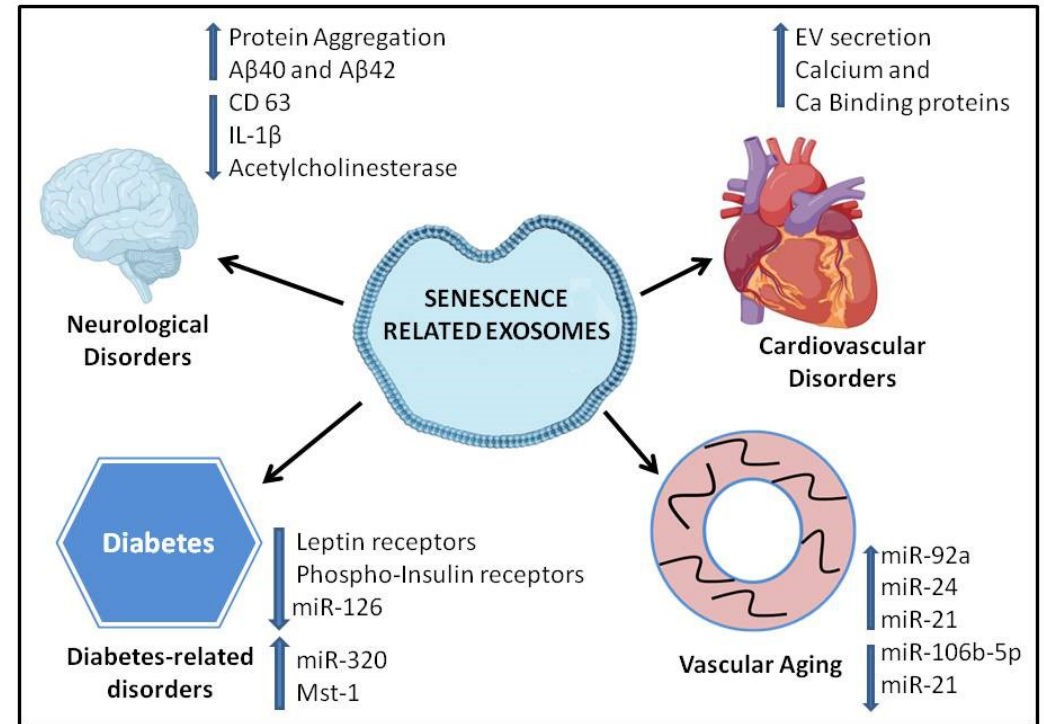
Figure 2. Age-related complications of senescent cell derived exosomes. Extracellular vesicles (EVs) secreted from senescent cells have been implicated in cardiovascular diseases, diabetes, neurological disorders, and vascular aging. Senescent EVs modulate several di ff erent proteins and miRs, thus exacerbating age-associated